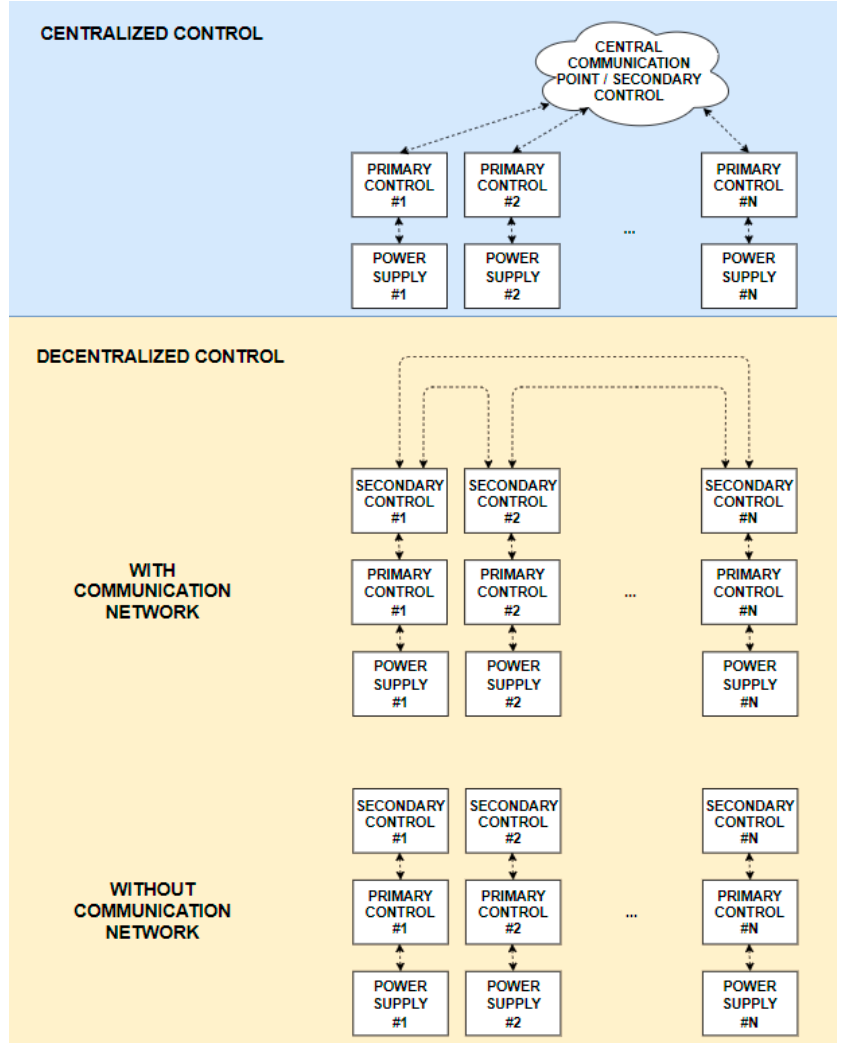
Figure 10. Secondary control strategies: centralized and decentralized (with/without communication network).